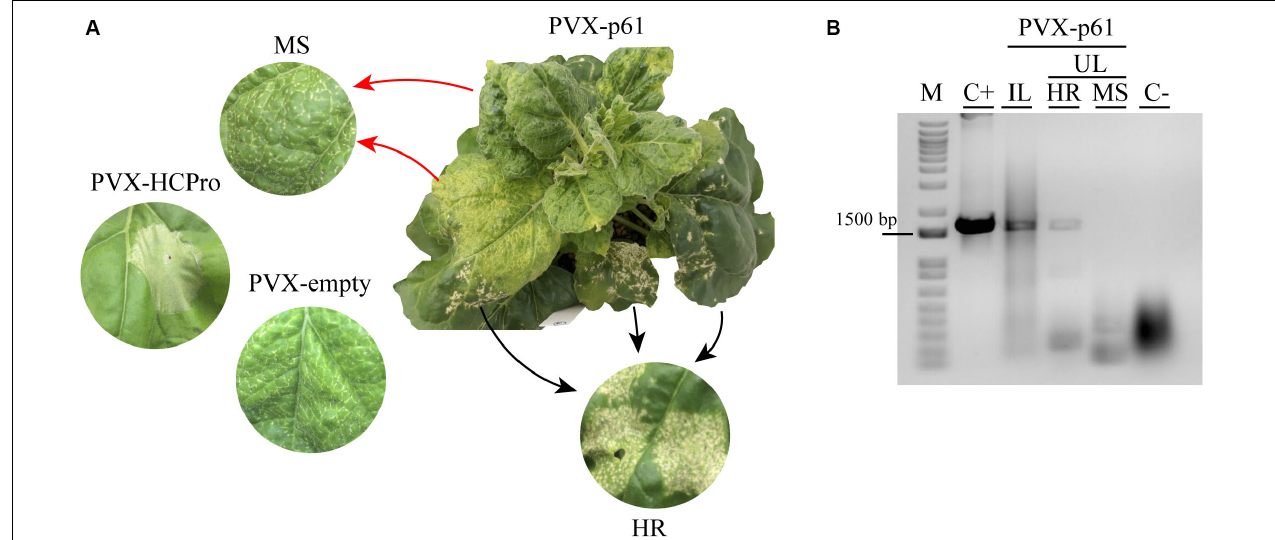
FIGURE 7 | The p61 expression on PVX infection generates a hypersensitive response (HR) phenotype. (A) N. benthamiana plant infiltrated with pGR107 PVX construct expressing p61 CiLV-C protein. Symptoms of hypersensitive response (HR) and a mosaic of symptoms (MS) are presented in the same upper leave from PVX-p61 infection at 3 dpi. The MS phenotype is also visualized in wild type PVX-empty infection. Necrotic lesions are observed in N. benthamiana plants infiltrated with pGR107 PVX construct expressing the RSS HCPro protein. (B) RT- PCR analysis to detect the p61 gene (1.650 bp) in inoculated (IL) and upper (UL) leaves of N. benthamiana plants inoculated with pGR107-p61 construct, exhibiting HR and MS symptoms. C+, RT-PCR from N. benthamiama leaves transiently expressing the p61 (positive control); C-, RT-PCR from uninfected plant sample. The marker band size of 1.500 bp is indicated. M, 1 kb DNA ladder (ThermoFisher Scientific Inc., United